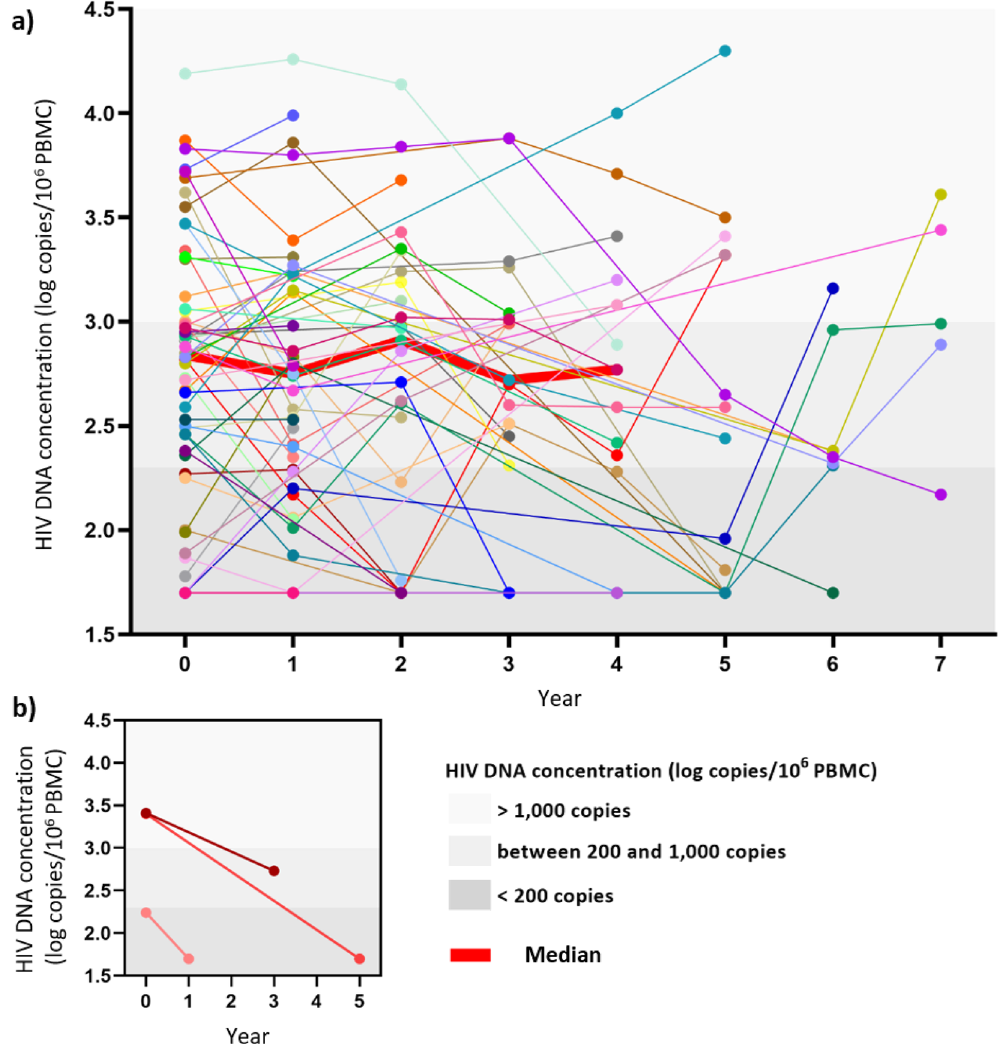
Figure 1. HIV reservoir follow-up study between 2014 and 2021. ( a ) HIV DNA quantification by qPCR from 2014 to 2021 in 48 PLHIV with prolonged virological success, where the y-axis shows the HIV DNA concentration (log 10 copies/10 6 PBMC copies), and x-axis the years (with 0 being the first quantification performed). ( b ) HIV-DNA quantification by qPCR in three patients initiating antiretroviral